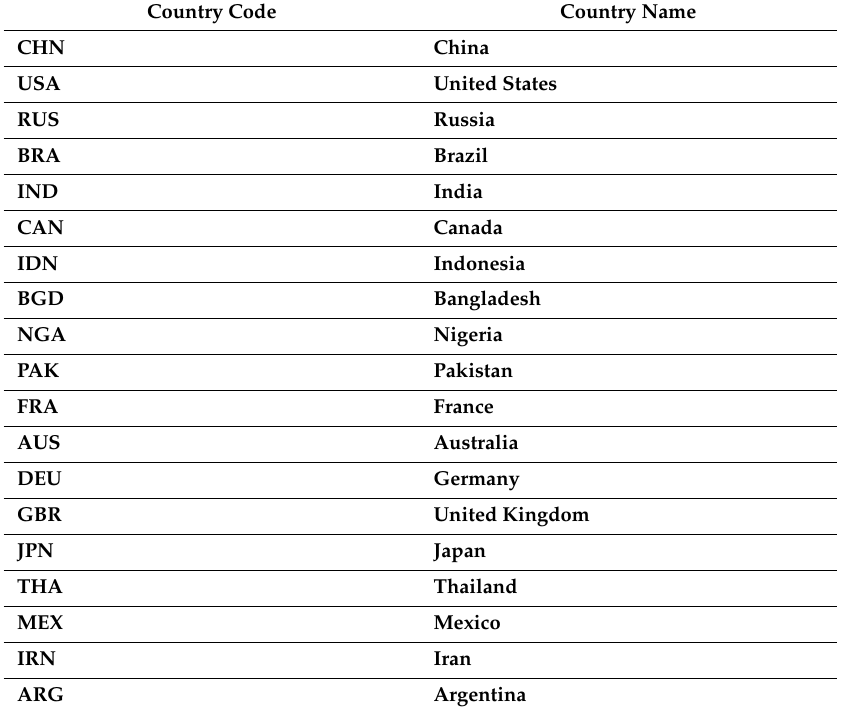
Table A2. List of country codes used in this paper and their respective names. The nineteen countries used for scaling the EDGAR using UNFCCC reports are listed in bold